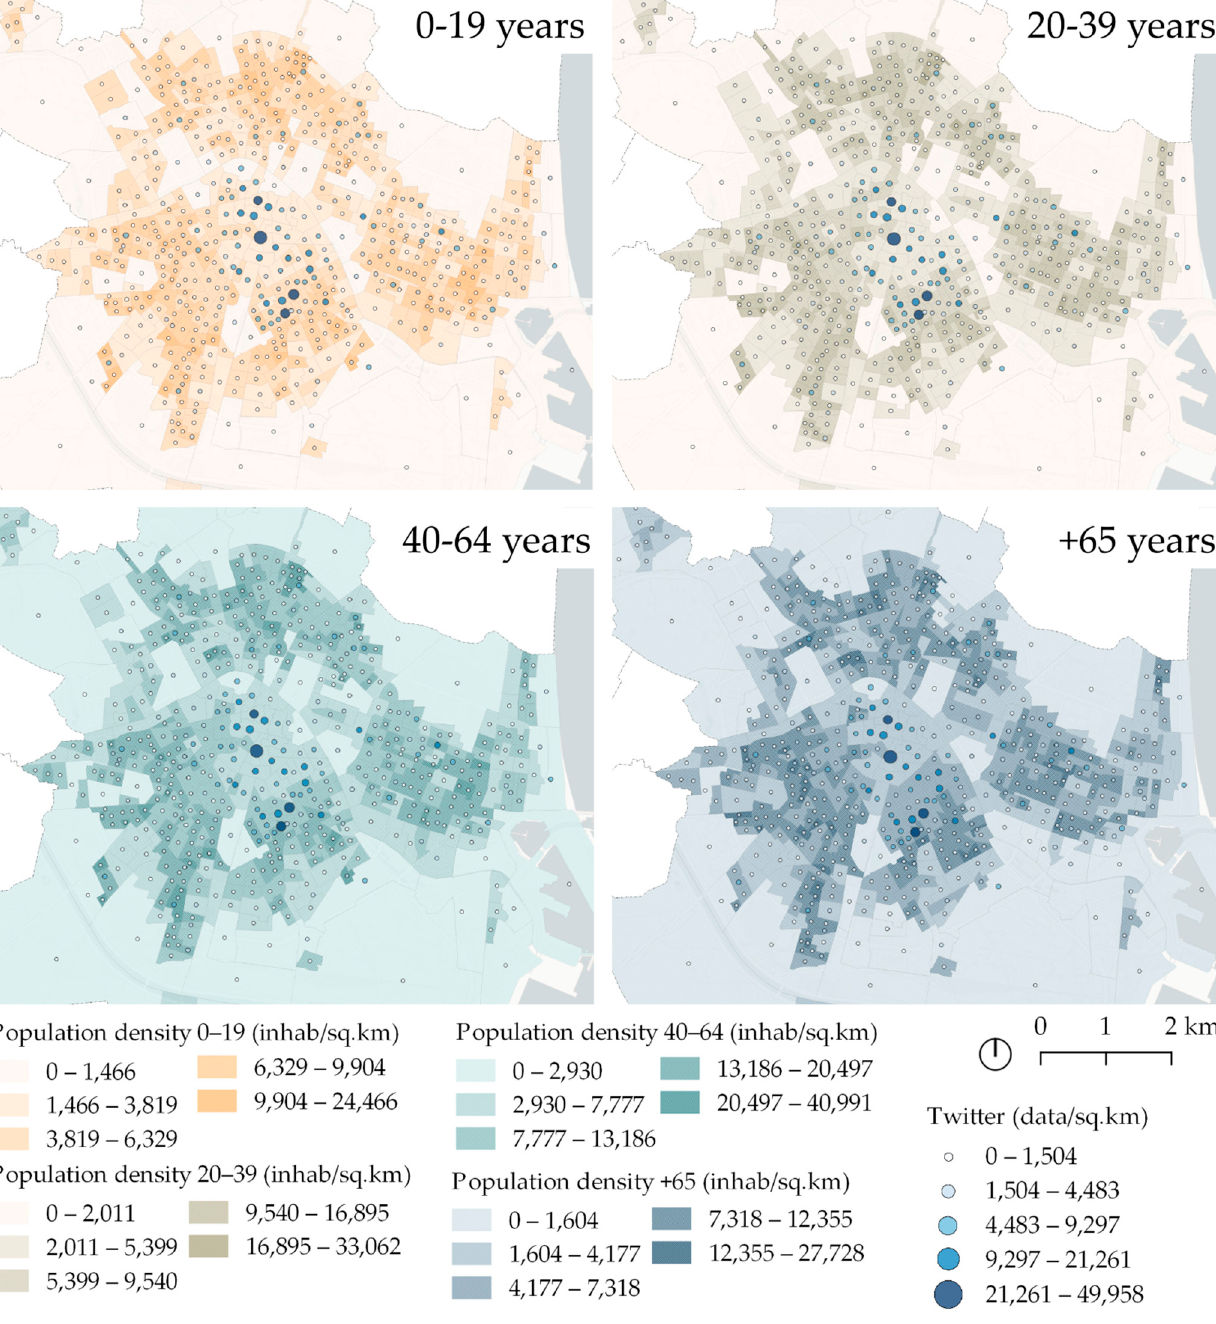
Figure 7. Population density per age group and Twitter data density.